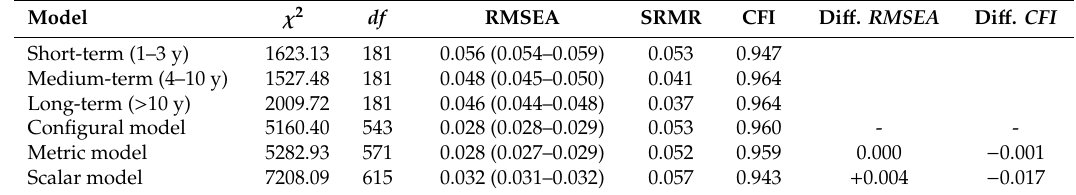
Table 5. Analysis of invariance regarding years of sport / exercise experiences.